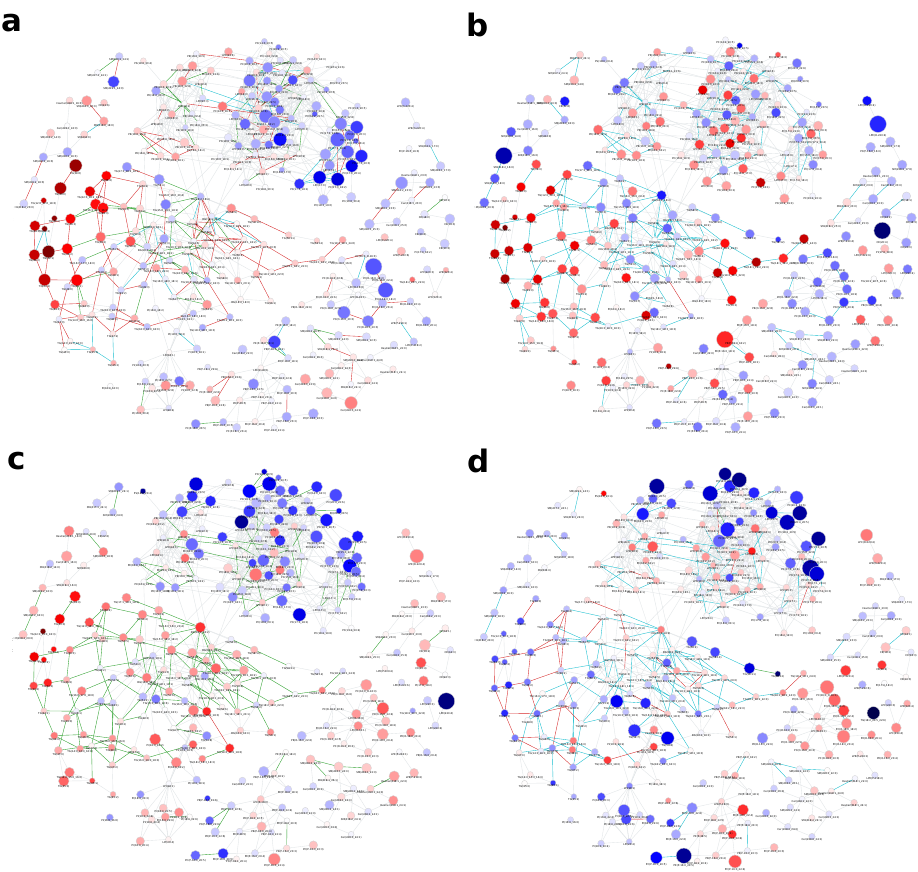
Figure 4. Global age-related plasma lipidome changes in a healthy human reference population from Kyle et al. [22]. Node colors represent log fold-changes with blue being negative, i.e., lower in the first condition, and red being positive. Node sizes are proportional to -log10(FDR) values. Edge colors indicate changes in correlation values between the respective conditions. For edge color groups see legend in Figure 2b. ( a ) Toddler vs. Child ( b ) Child vs. Teenager ( c ) Teenager vs. Adult ( d ) Adult vs.